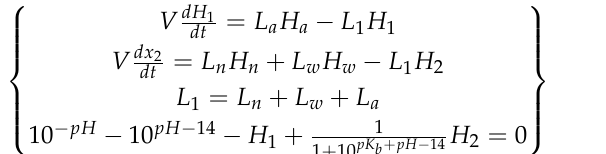
Figure 2. Fertilizer pH adjustment concentration analysis chart.